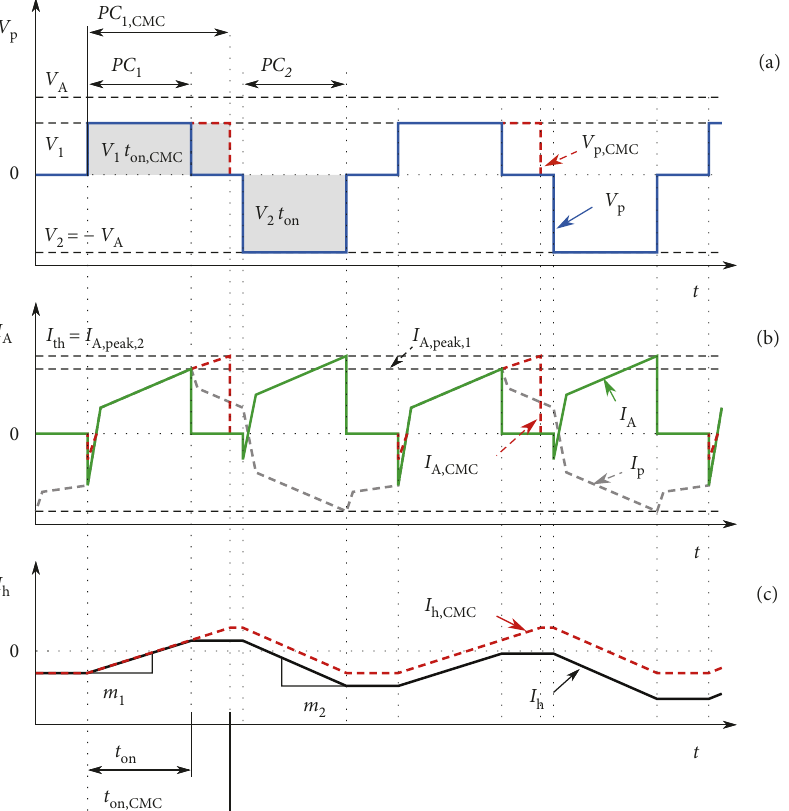
Figure 3: CMC compensation principle of PSFB with a present flux imbalance at transformer. (a) shows the primary voltage V input current I and (c) the magnetizing current I A I and results in an increasing negative DC-offset I A , peak , 1 symmetrical voltage-second